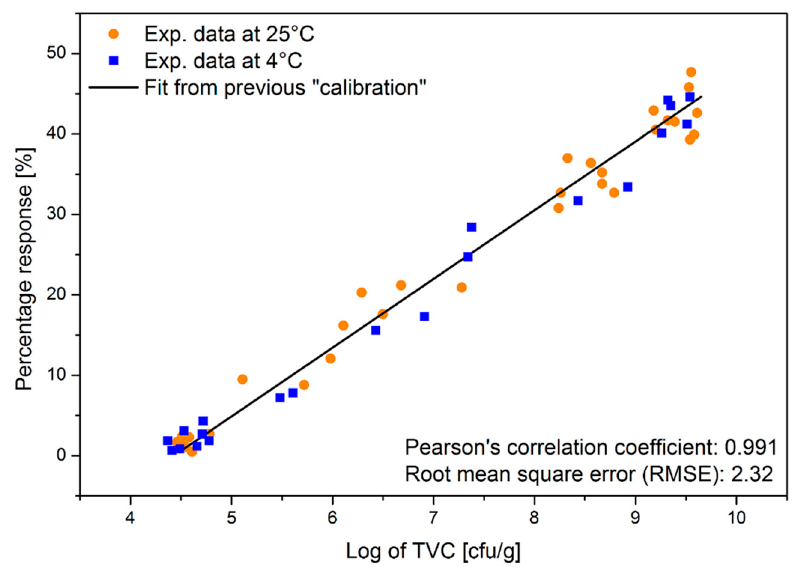
Figure 10. Correlation between sensor response and total viable count (TVC) for measurements of samples at random spoilage level.